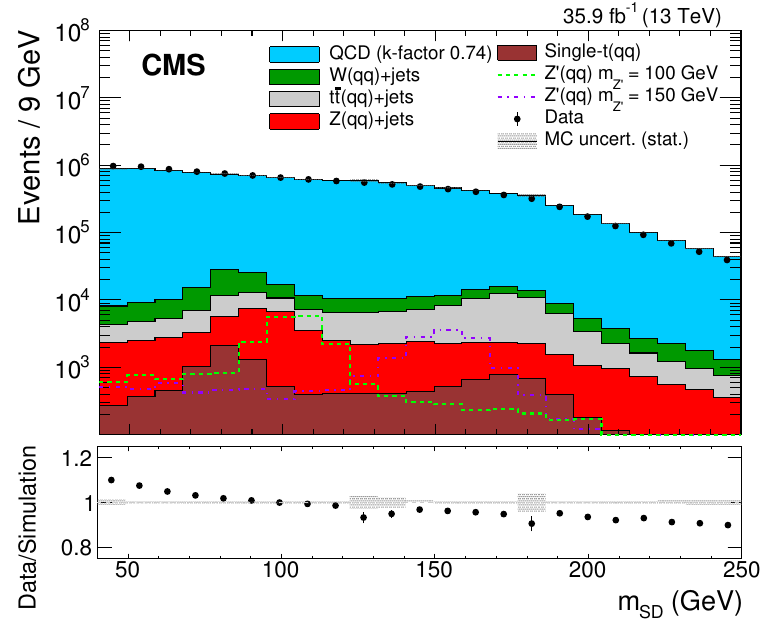
Figure 1 . Distributions of data (points) and simulated backgrounds (histograms), of the leading p T jet soft-drop mass after the jet kinematic selection. Dashed lines illustrate the signal contribution for di(cid:11)erent Z 0 boson masses. The multijet processes (QCD) dominate the background component, with subdominant contributions from inclusive SM W, Z, and tt and single top quark